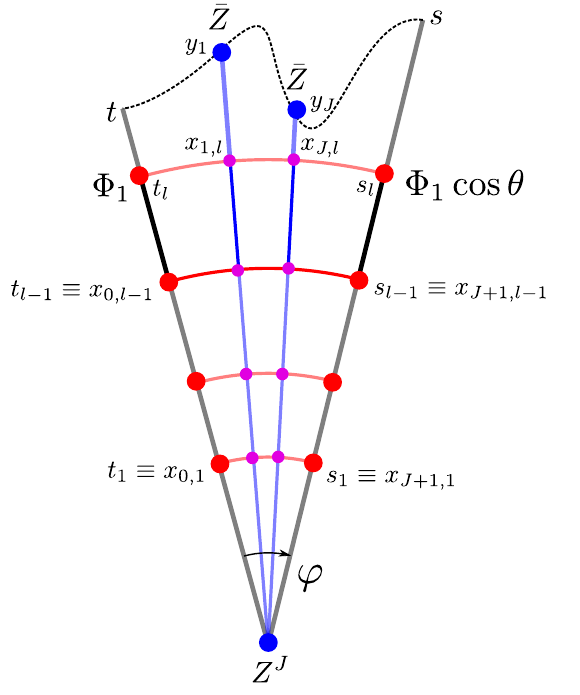
Figure 1. The CFT wavefunction for J = 2 is a sum of the fishnet diagrams with any number of bridges. This figure shows one such diagram with l = 4 bridges. The graph building operator is